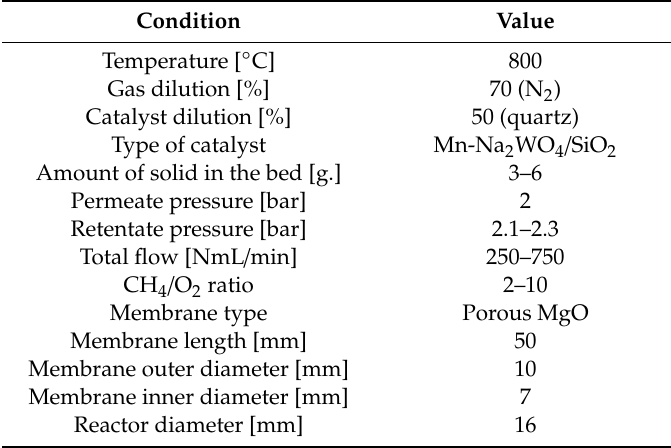
Table 1. Summary of conditions and parameters used for the experiments carried out in this